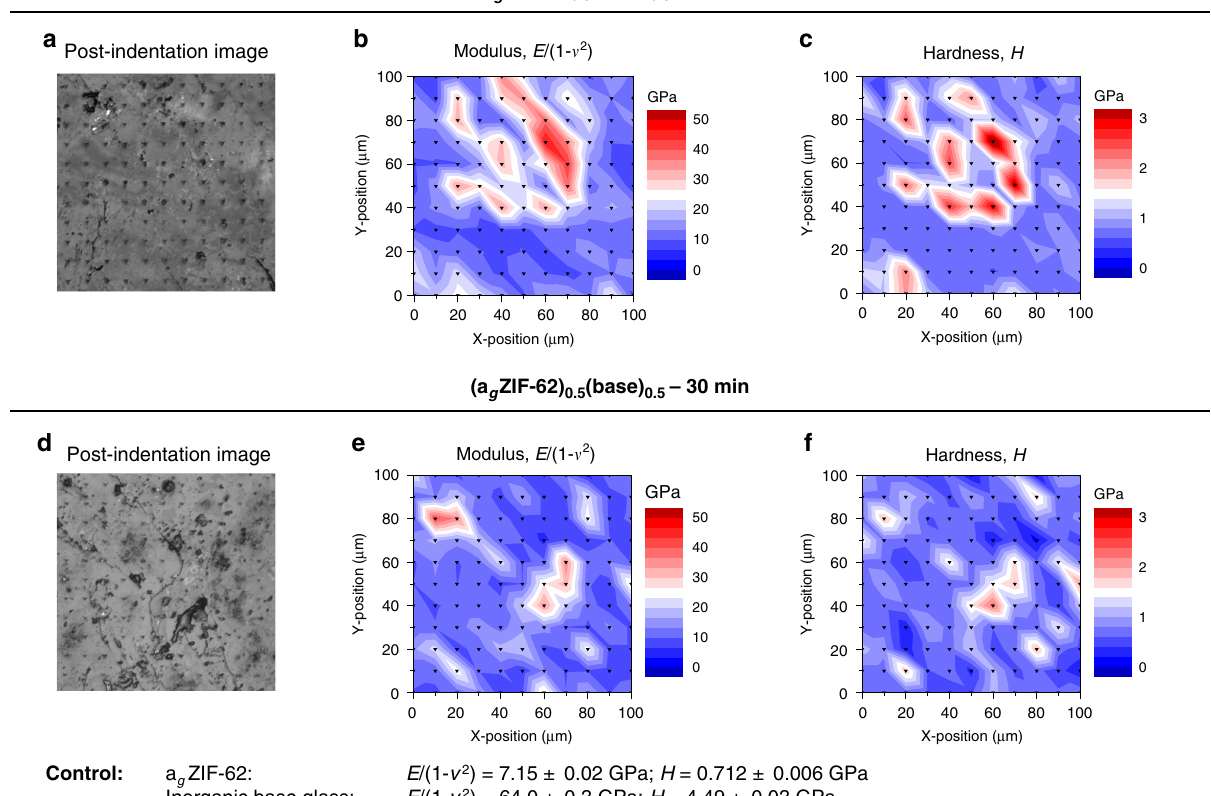
Fig. 4 Mechanical properties variation. Modulus ( E ) and hardness ( H ) contour maps together with wide- fi eld confocal microscopy images of the area mapped across the surface of the (a g ZIF-62) 0.5 (base) 0.5 compositions heat treated for 1 minute a – c and 30 minutes d – f